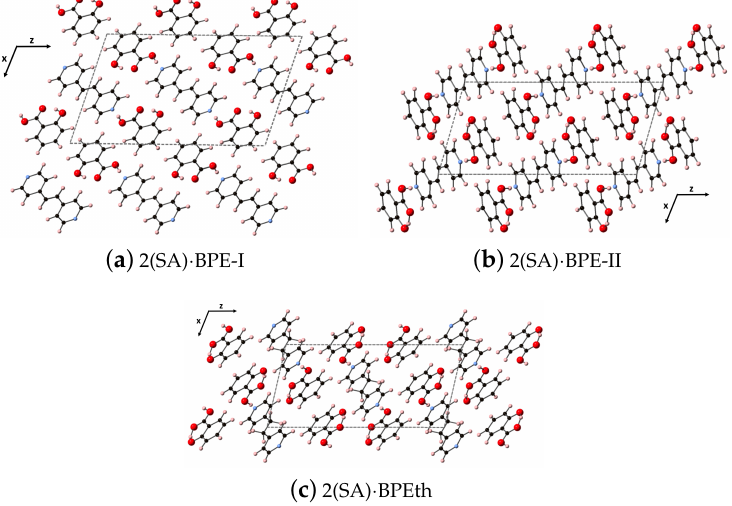
Figure 8. Shown here are the co-crystals ( a ) 2(SA) · BPE-I; ( b ) 2(SA) · BPE-II; and ( c ) 2(SA) · BPEth. Color scheme is as before in Figure 1.